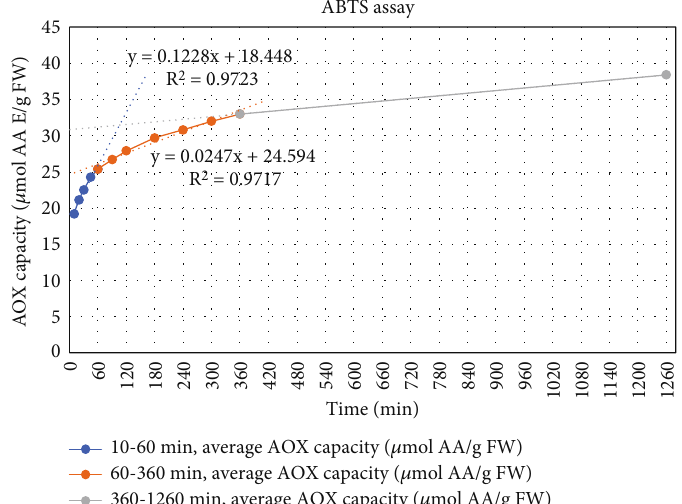
Figure 2: AOX capacities of the same sample at di ff erent incubation time points.